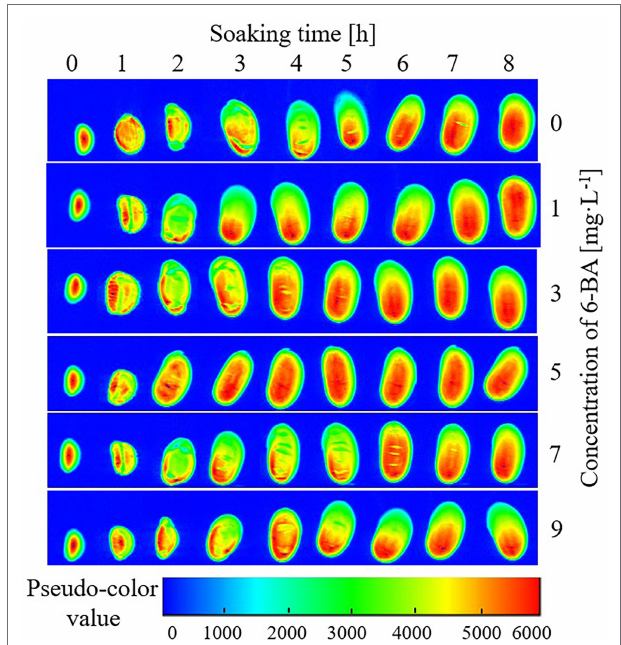
FIGURE 1 | Pseudo-color map of continuous time points during soybean soaking in 6-BA solution with different concentrations. The larger the pseudo- color value, the greater the hydrogen proton density in the experimental